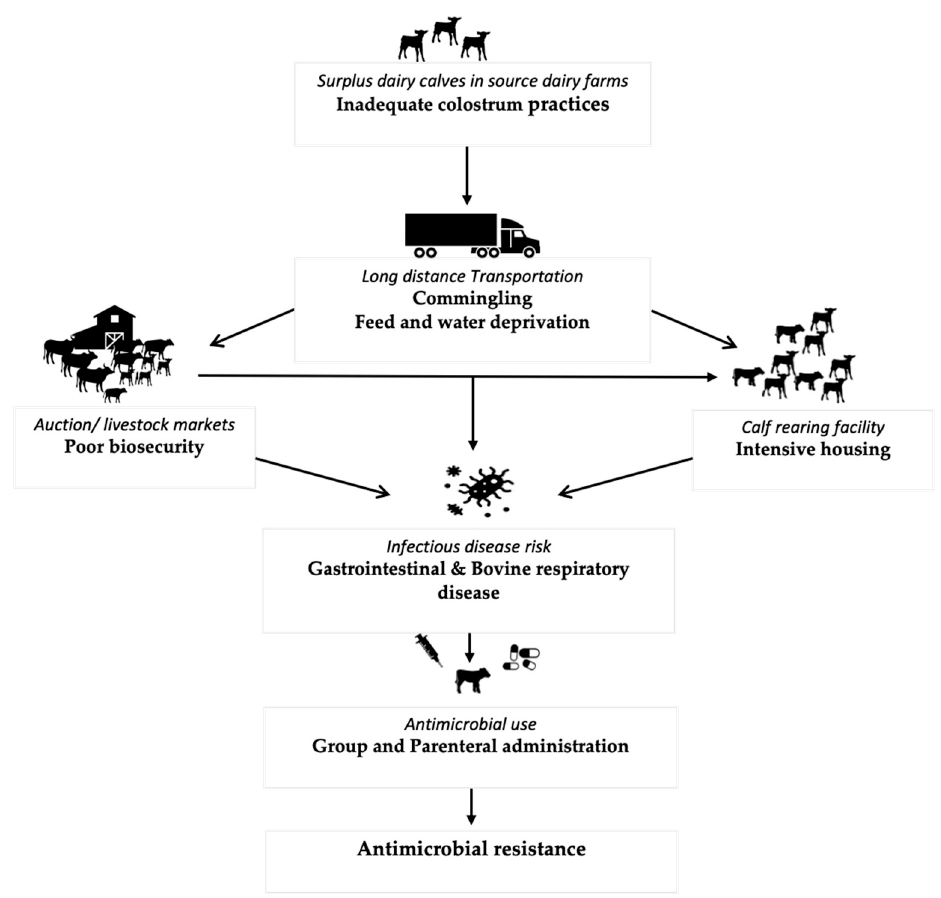
Figure 1. Events and causal pathways in surplus calf production leading to increased infection risk and subsequent AMU.